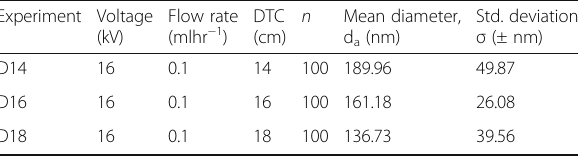
Table 2 The diameter size distribution of nanofiber for all the sample with different DTC Experiment Voltage (kV)